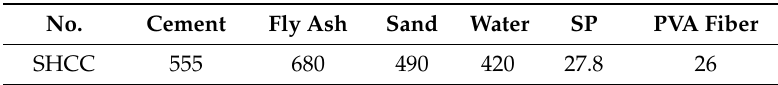
Table 2. Mix proportion of SHCC (kg / m3).